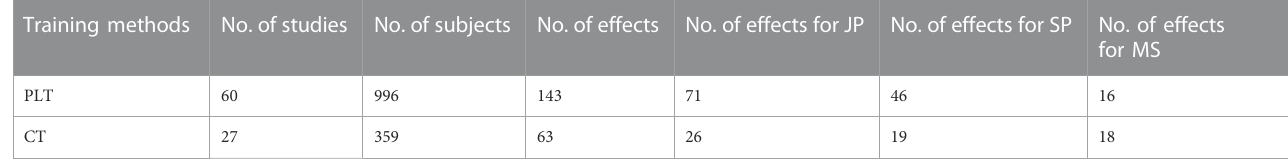
TABLE 3 Training participants and effects